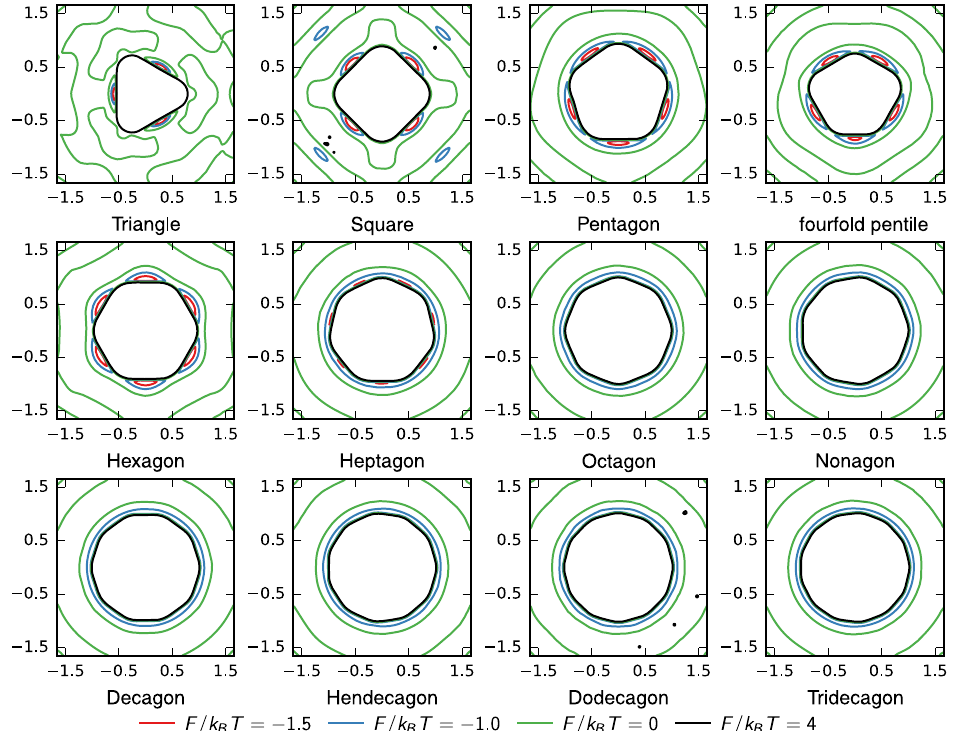
FIG. 6. Potential of mean force and torque plots for polygons n ¼ 3 – 13 computed at the highest density isotropic fluid for each polygon. We choose the zero energy reference as the average over a large region 25 σ from the center (not shown). The data are shown as a contour plot with selected free energy or entropy well contours. Computed from N ¼ 256 2